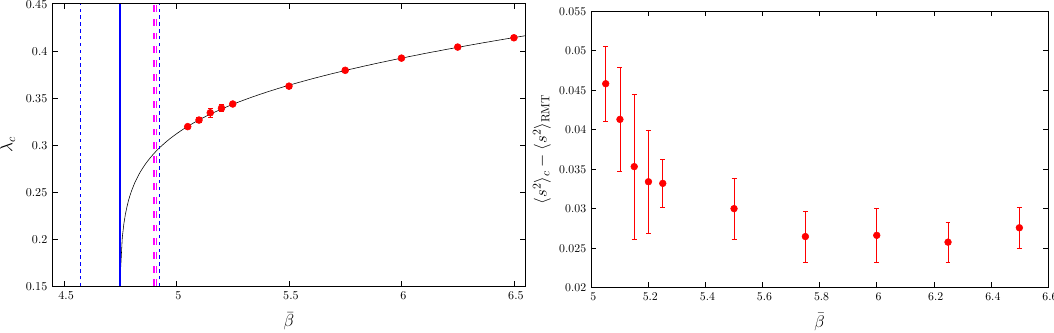
Figure 10 . Mobility edge λ c (in lattice units) obtained via constrained fitting using deviation of the corresponding value s 2 of the statistic at the critical point from the RMT value h i c (right). The result of a fit of λ c with eq. (4.8) is also shown (solid line), together with the value ¯ β 0 at which the mobility edge extrapolates to zero and corresponding error band (blue lines), and with the error band for the critical lattice coupling for deconfinement obtained in ref. [49] (magenta lines).